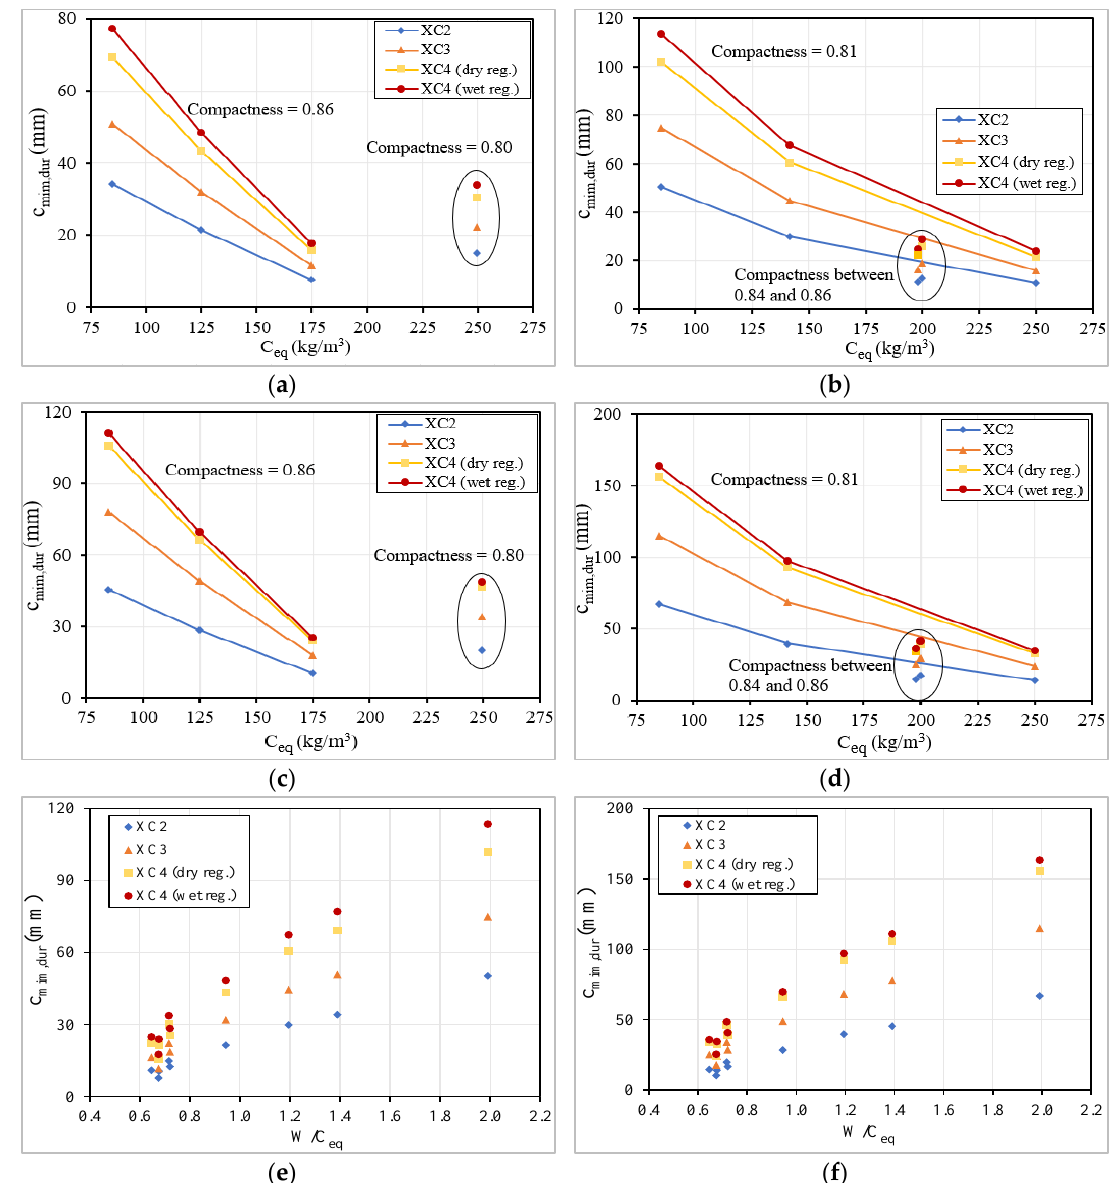
Figure 23. Relation between the c min,dur vs. dosage of C eq and between c min,dur vs. W / C eq .:( a ) current structures, total powder 250 kg / m 3 ; ( b ) current structures, total powder 350 kg / m 3 ; ( c ) special structures, total powder 250 kg / m 3 ; ( d ) special structures, total powder 350 kg / m 3 ; ( e ) current structures; ( f ) special